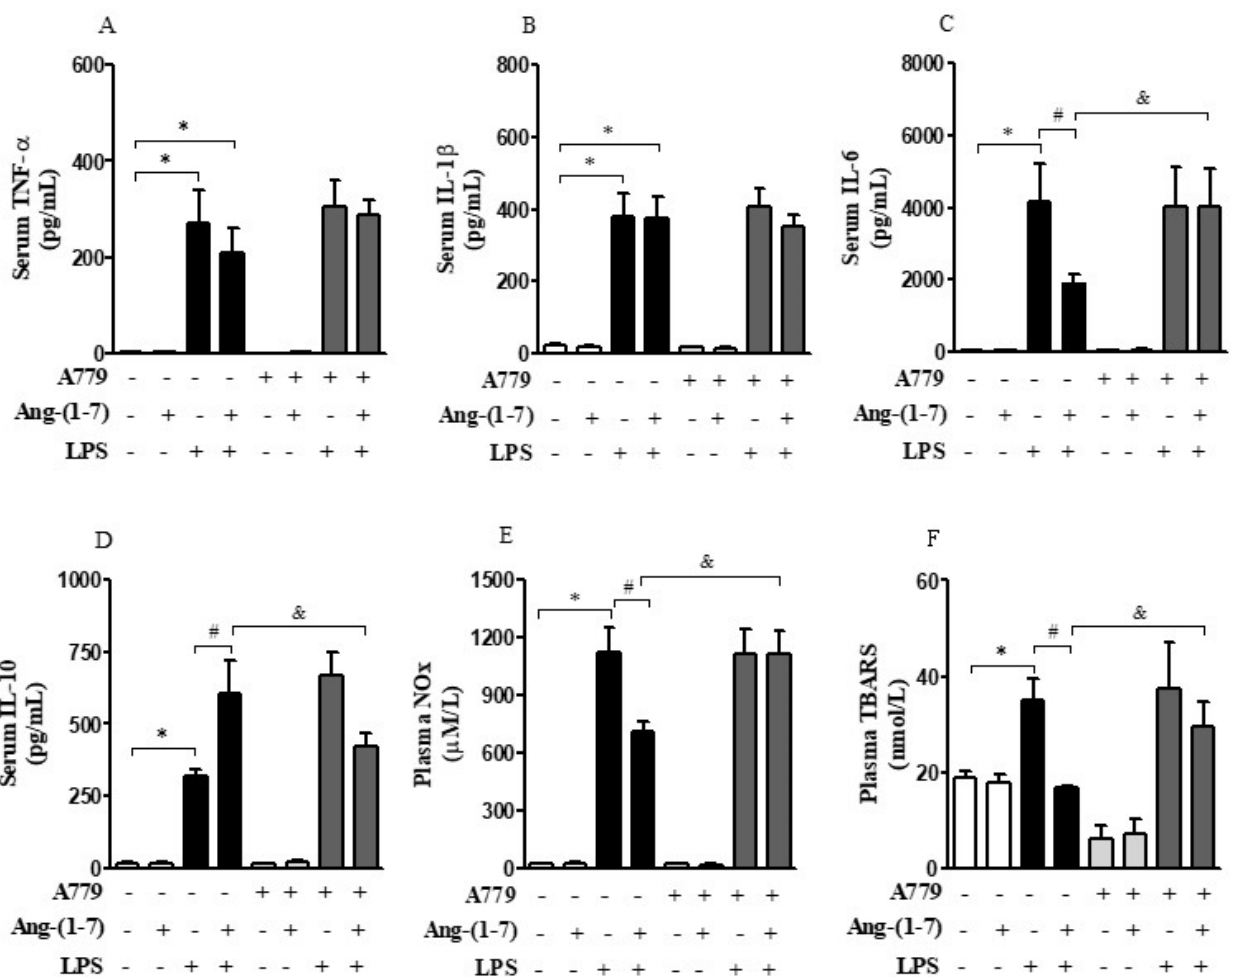
Figure 2. Central administration of Ang-(1-7) attenuated systemic inflammation in endotoxemic rats via Mas receptor. Effect of central Ang-(1-7) on the TNF- α ( A ), IL-1 β ( B ), IL-6 ( C ), IL-10 ( D ), NOx ( E ), and TBARS ( F ) levels in rats 6 h after LPS administration (1.5 mg/Kg, i.v.). A779 (3 nmol in 2 µL, i.c.v.), a selective antagonist for Mas receptor, was injected 30 min before Ang-(1-7) administration (0.3 nmol in 2 µL, i.c.v.). Data are expressed as the mean ± SEM, n = 7–12. ANOVA, followed by Bonferroni post-hoc test. * p < 0.05 versus Saline (i.c.v.) + Saline (i.v.) group, # p < 0.05 versus Saline (i.c.v) + LPS (i.v.) group, and & p < 0.05 versus Ang-(1-7) (i.c.v) + LPS (i.v.) group.